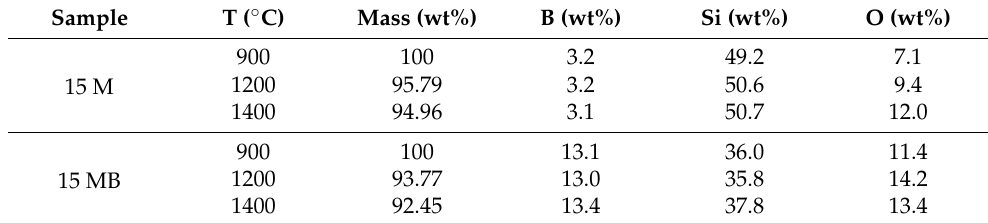
Table 3. Air oxidation of the 15 M and 15 MB ceramic products.